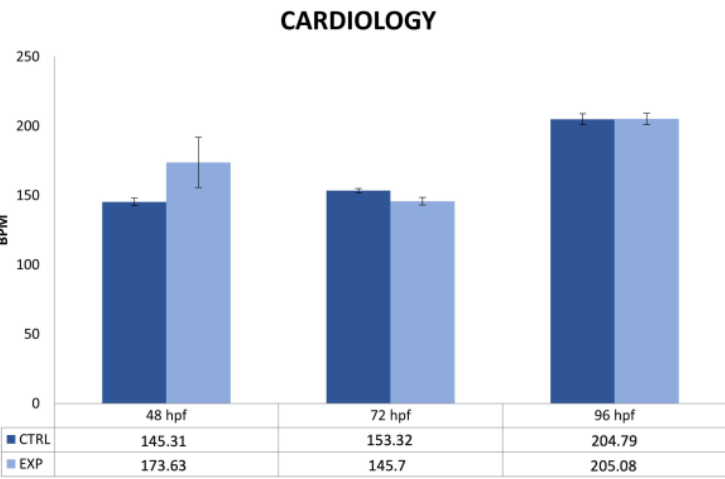
Figure 4. Beats per minute (BPM) values of the control group and embryos exposed to 27 GHz obtained by DanioScope™ software. Under the histograms, the number of BPM found at each stage (expressed as a mean) is shown.